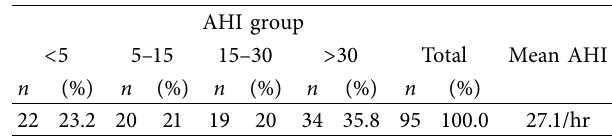
Table 2: Distribution of OSA patients according to AHI groups.